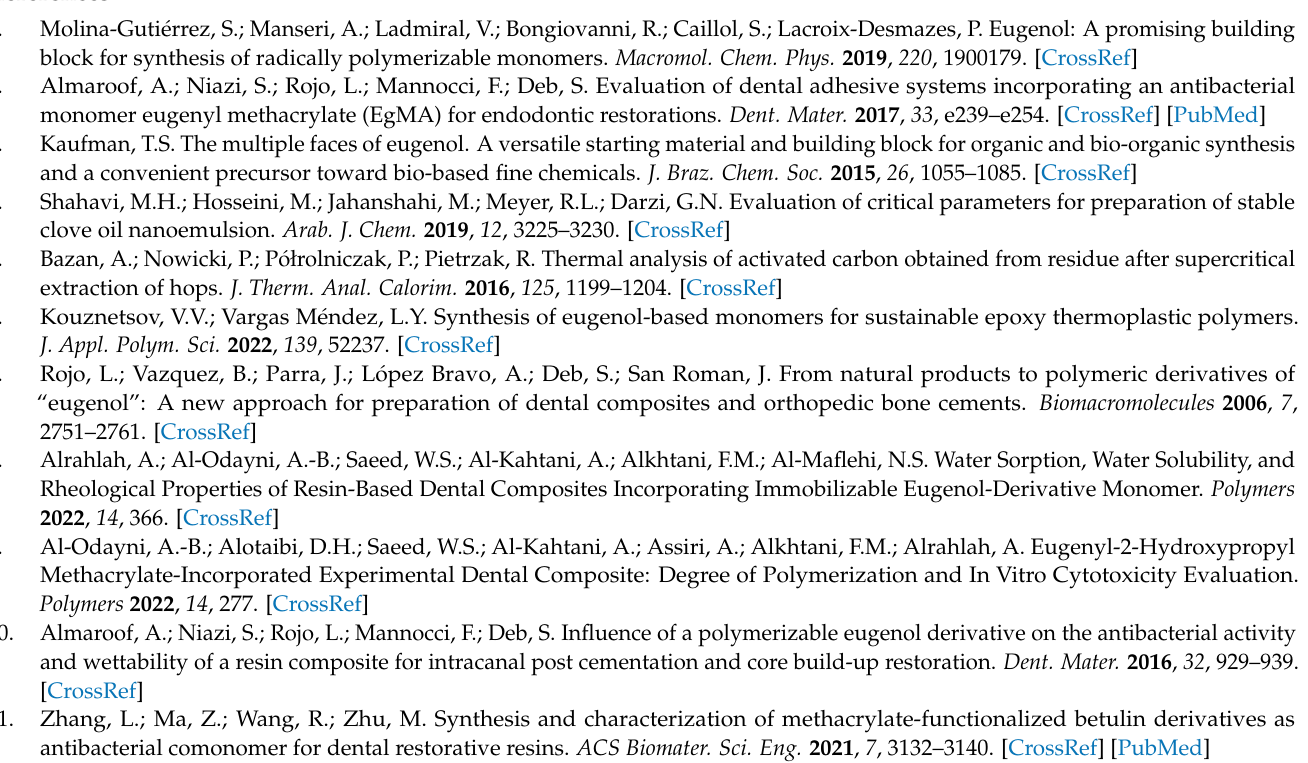
Figure S2: Proposed mass fragmentation route of EgGAA monomer; Figure S3: Chemical struc- ture of BisGMA, UDMA, TEGDMA and EgGAA monomers. Table S1: FTIR bands of Eg, GMA, EgGMA, and EgGAA monomers; Table S2: 1 H- and 13 C NMR peaks assignments of Eg, GMA, EgGMA, and EgGAA; Table S3: Experimental and calculated mass the fragments of molecular ion; Table S4: Thermal decomposition of EgGAA monomer; Table S5: DSC data of BisGMA, TEGDMA and EgGAA